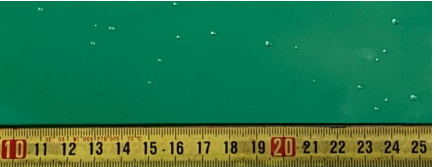
Figure 2. Raindrops collected on a rainy day (outdoor tests). The ruler on the bottom is used only to give an order of magnitude.